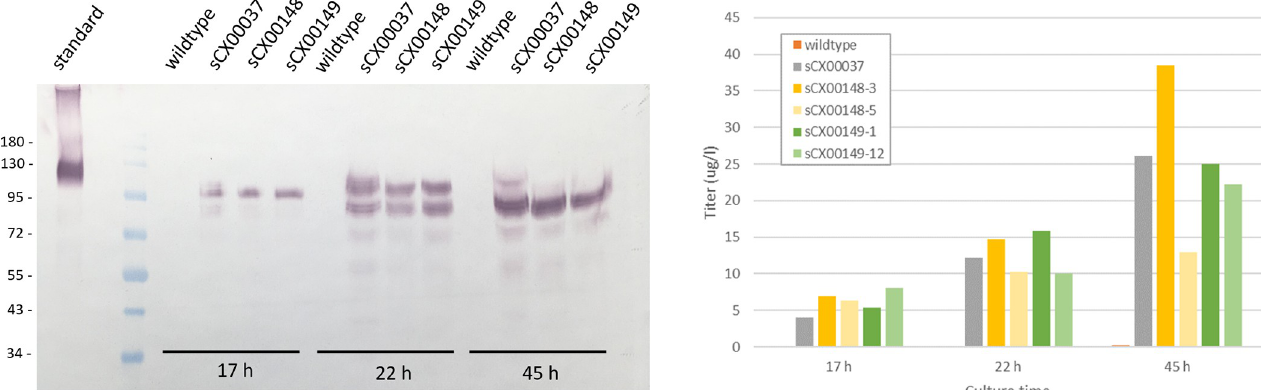
Fig 3. a. Expression and secretion of ACE2. Strain sCX00037 produced full-length ACE2, while strains sCX00148 produced a truncated form of ACE2. After prolonged incubation, some clipping of the produced ACE2 is noticeable. The specificity of the detection antibody was confirmed by the absence of bands in the wildtype samples. b. Titers of produced ACE2. Titers were determined using a sandwich ELISA. A steady increase in titers was seen, but as the western blot shows, this came with an increase in clipped